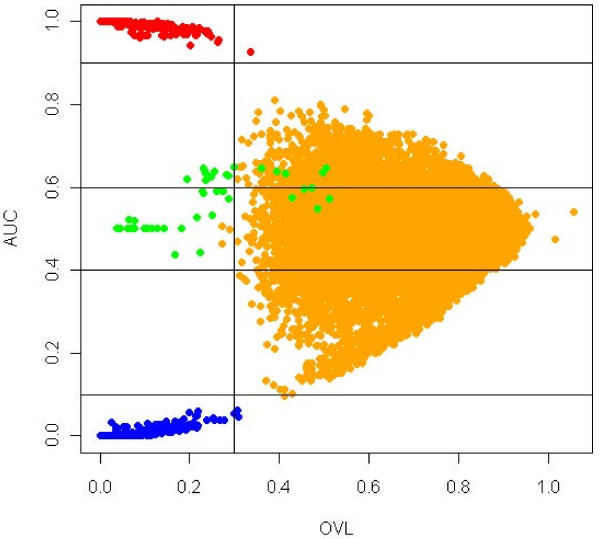
Arrow plot of simulated data. Orange dots correspond to truly no differentially expressed genes, red dots correspond to truly up-regulated genes, blue dots correspond to truly down-regulated genes and green dots to truly special genes. We considered as up-regulated genes those for which AUC≥ 0.9 and an OVL< 0.5. To select down-regulated genes an AUC≤ 0.1 and an OVL< 0.5 were considered and to select differentially expressed genes with bimodal or multimodal densities we considered an OVL< 0.5 and 0.4 <AUC< 0.6.